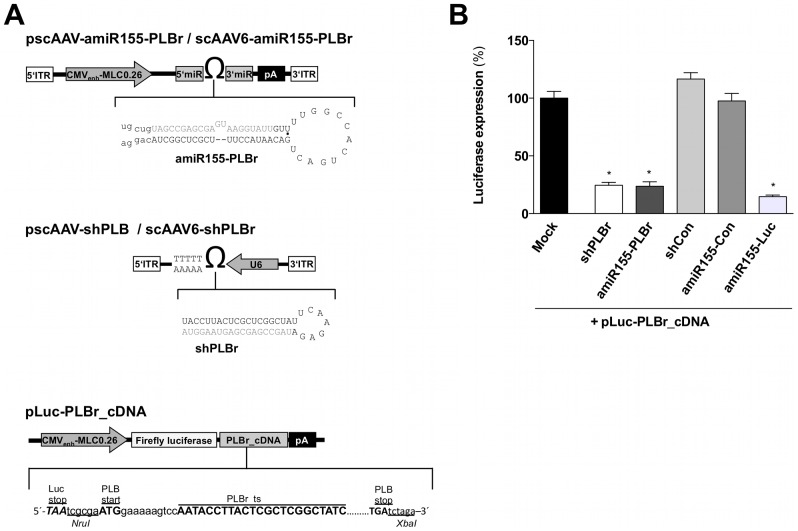
Scheme of miR-155-PLBr and shPLBr expressing vectors as well as of a luciferase PLB cDNA reporter gene plasmid (A) and luciferase expression in HEK293 cells co-transfected with either PLB silencing or non-silencing control plasmids (B).(A) Schematic representation of the amiR155-PLBr, shPLBr and luciferase reporter vectors. Upper panel: The amiR155-PLBr and shPLBr were inserted into an AAV shuttle plasmid containing an AAV2 vector backbone. The structure and nucleotide sequence of the amiR155-PLBr and shPLBr are shown below the vector scheme. The antisense strand of the mature amiR155-PLBr and shPLBr is highlighted in grey. Middle Panel: The shPLBr expression is driven by an U6 polymerase III promoter and terminated by five consecutive thymidines. The amiR155-PLBr expression is driven by a CMV-enhanced 0.26 kb rat MLC hybrid polymerase II promoter (CMVenh-MLC0.26) and terminated by a SV40 poly A signal (pA). Note: The 3′ ITR of the AAV genome has a mutation in the terminal resolution site resulting in self complementary AAV vector genomes after packaging into AAV6 capsids. Lower panel: Schematic illustration of plasmids containing the Firefly luciferase reporter gene and the PLB cDNA (pLuc-PLBr_cDNA) in its 3′UTR. (B) Silencing activity of shPLBr and amiR155-PLBr using reporter assays. HEK293 cells were transfected with pLuc-PLBr_cDNA and Renilla luciferase expression plasmid and cotransfected with either amiR155-PLBr or shPLBr expressing plasmids. In addition, cotransfection was also done using the respective control plasmids amiR155-Con, shCon and amiR155-Luc. Cells were harvested 72 h after transfection and luciferase activity was determined. Firefly luciferase expression signals of the pLuc-PLB_cDNA reporter were normalized to Renilla luciferase and related to the respective signals in exclusively with Firefly luciferase expression vector transfected cells (Mock). *p<0.01 vs. respective control.